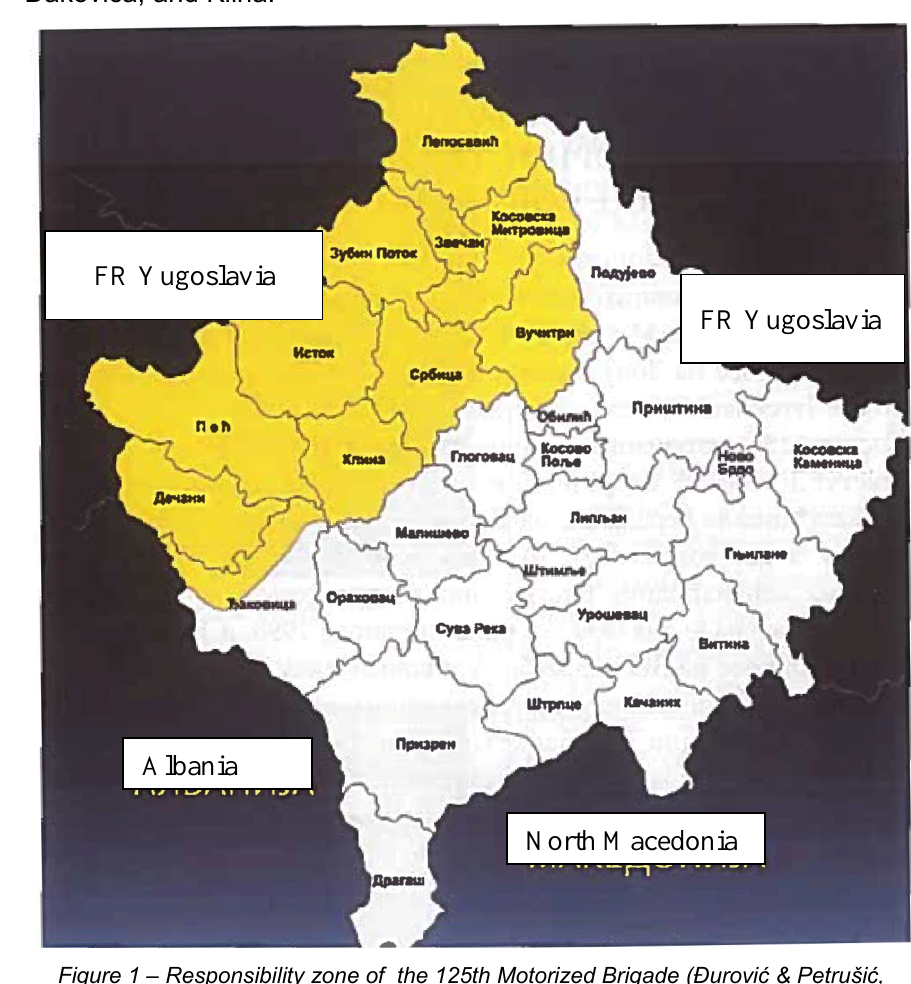
Figure 1 – Responsibility zone of the 125th Motorized Brigade ( Đ urovi ć & Petruši ć , 2016, pp.137-138) Рис . 1 – Зона ответственности 125- й моторизованной бригады ( Đ urovi ć & Petruši ć , 2016, pp.137-138) Слика 1 – Зона одговорности 125. моторизоване бригаде ( Đ urovi ć & Petruši ć , 2016, pp.137-138)